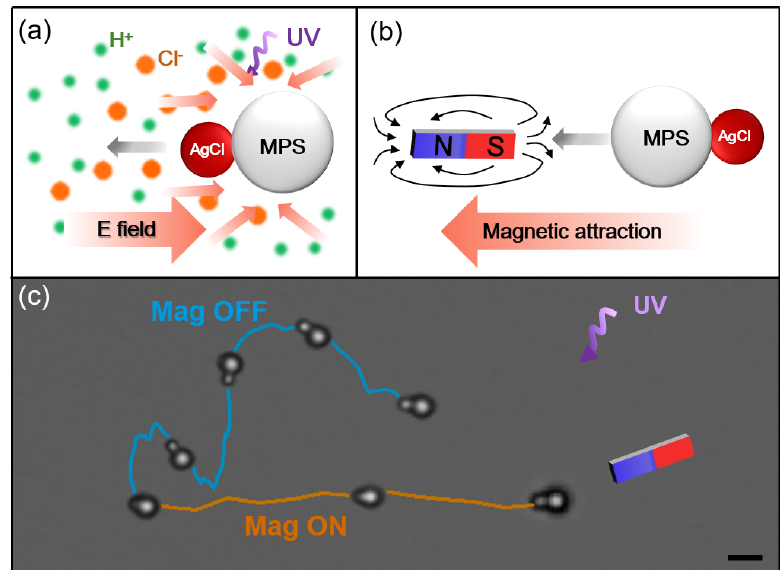
Figure 5. ( a , b ) Schematic diagrams showing the light-activated motion due to the AgCl particle, and the magnet-activated motion due to the magnetic PS particle (MPS). ( c ) Trajectory of MPS − AgCl particle moving under UV light (cyan line) and magnetic field (orange line). Superimposed time-lapse snapshots of active colloids demonstrate the orientation of the particles. Scale bar: 2 µm.